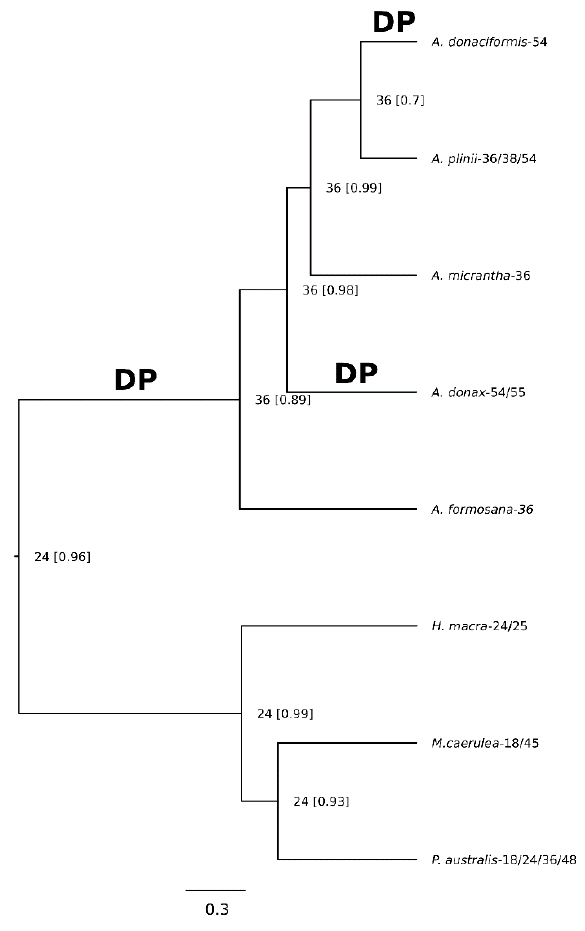
Figure 5. Chromosome number evolution and inferred ancestral chromosome state in the genus Arundo , including three outgroups, inferred under Bayesian optimization. For each node, the most probable ancestral haploid chromosome number is reported. Numbers in square brackets are posterior probabilities. Numbers at the tips are the most frequent known haploid chromosome numbers of each species. DP: inferred demipolyploidization